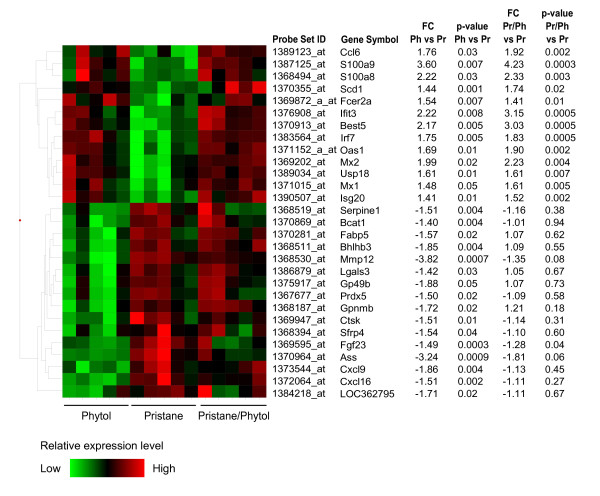
Hierarchical clustering of differentially expressed genes in phytol-treated compared with pristane-treated rats. Euclidean distance was used as a similarity measure. Each column represents one individual rat, and each horizontal stripe represents a gene transcript. The Affymetrix probe set identification, the gene symbol, the average fold change (FC) for phytol versus pristane together with the p value, and the average fold change for phytol/pristane versus pristane and its p value are given to the right. The colors in the clustering represent the gene-expression level in each individual rat compared with the average expression in all arrays, where green indicates low expression and red represents high expression.